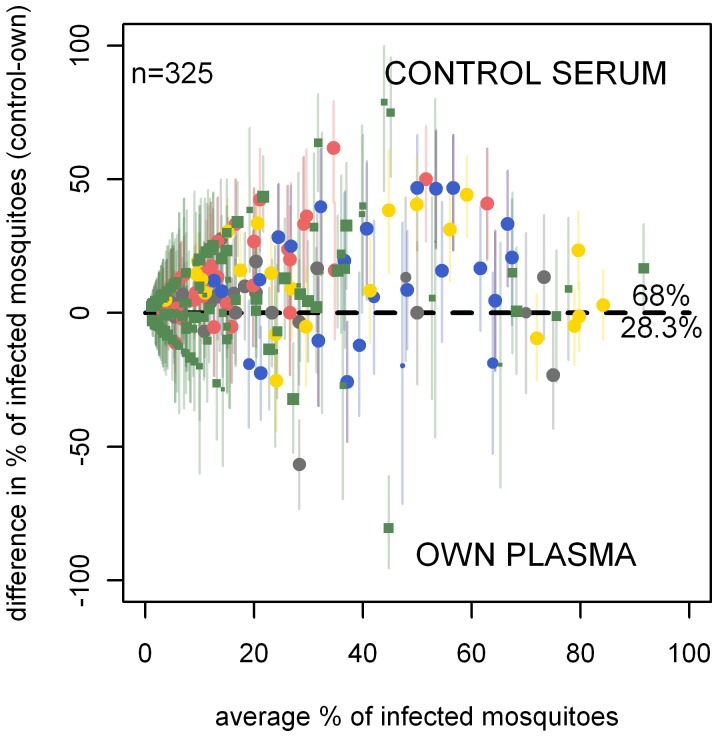
Membrane feeding with and without serum replacement.The results are from 325 paired experiments. In 221 experiments (68.0%), the proportion of infected mosquitoes was higher in experiments with malaria naïve control serum compared to the gametocyte donor's own plasma; in 92 experiments (28.3%) the opposite was observed. The shape of the point denotes the country the experiment was carried out in, be it Cameroon (circle) or The Gambia (square). Point size, shape and colour are as described in Figure 3.